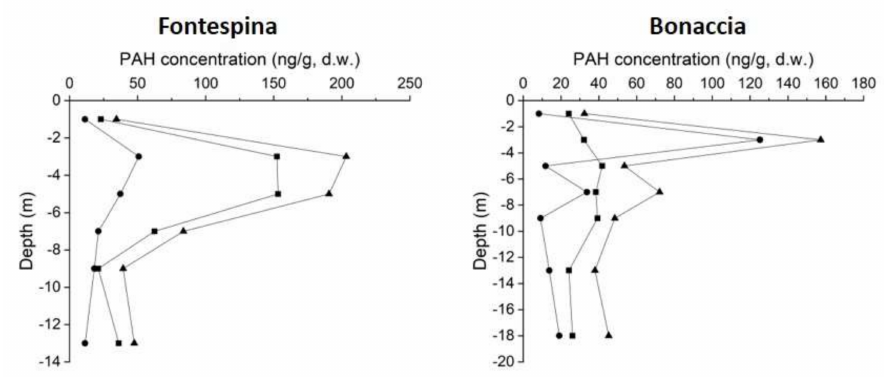
Figure 10. Total PAH concentrations ( (cid:78) ), PAHs with low molecular weight, LMW ( • ) and PAHs with high molecular weight, HMW ( (cid:4) ) recorded in the sediment layer of the reference site (REF) for Fontespina and Bonaccia sites.